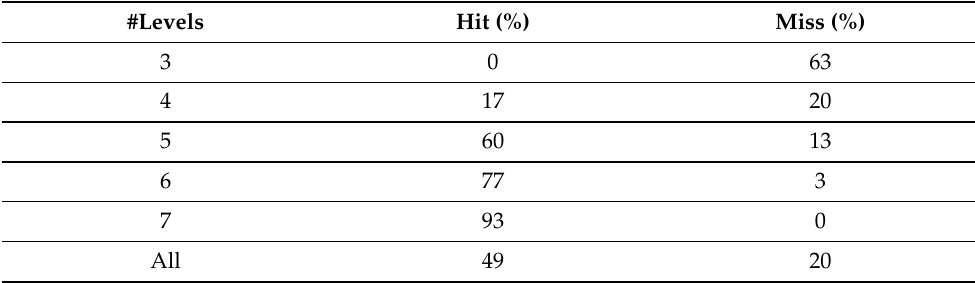
Table 4. Improvement of CARRY-MAP with respect to VIV-MAP in speed optimization taking into account both area and